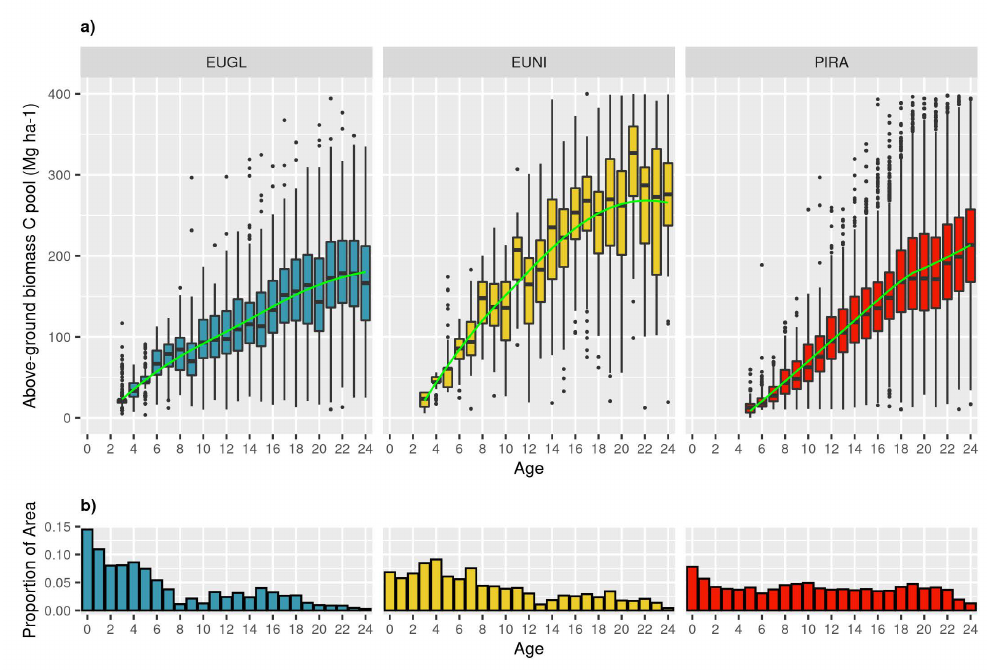
Figure 6. ( a ) Distribution of the above-ground biomass C density [Mg · ha − 1 ] according to age for E. globulus (EUGL) ( n = 6952), E. nitens (EUNI) ( n = 2511), and P. radiata (PIRA) ( n = 40,363). Green